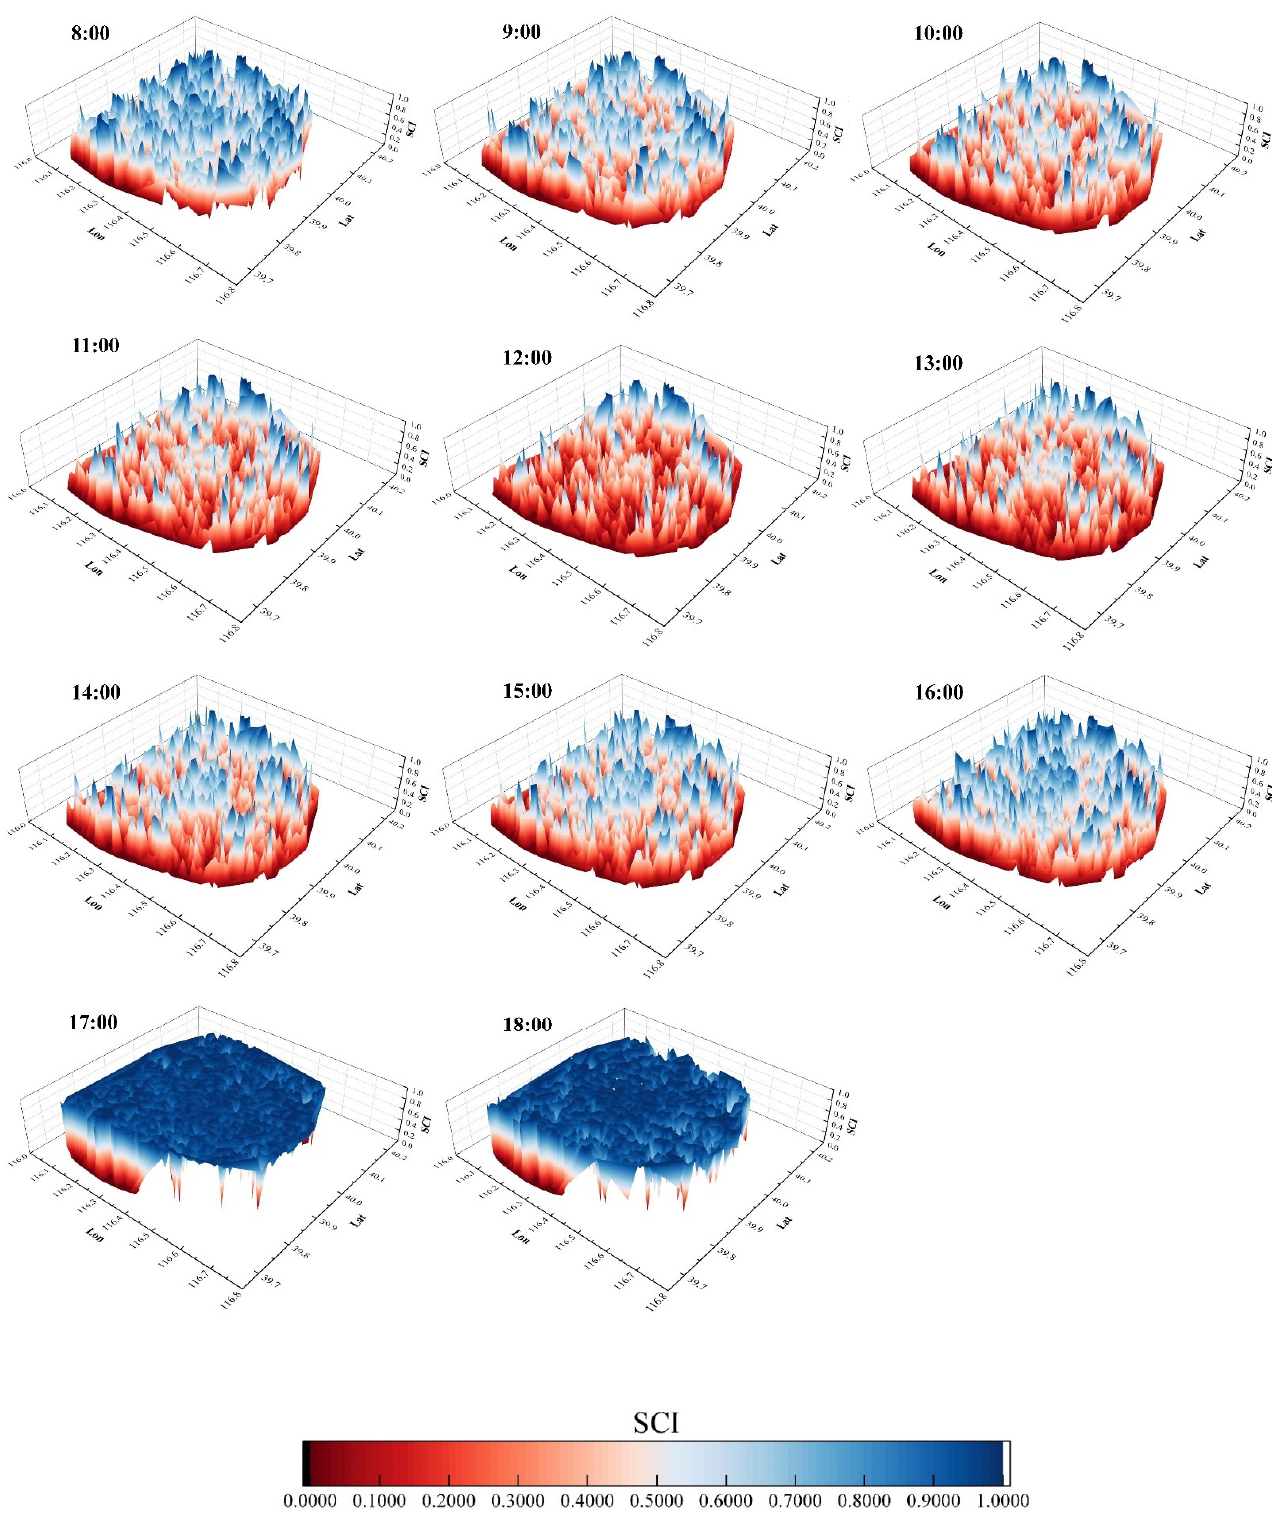
Figure 7. The three-dimensional map of shading coverage index in the 1 km grid. The x- and y-axes, respectively, represent the latitude and longitude, the z-axis represents the value of shading coverage